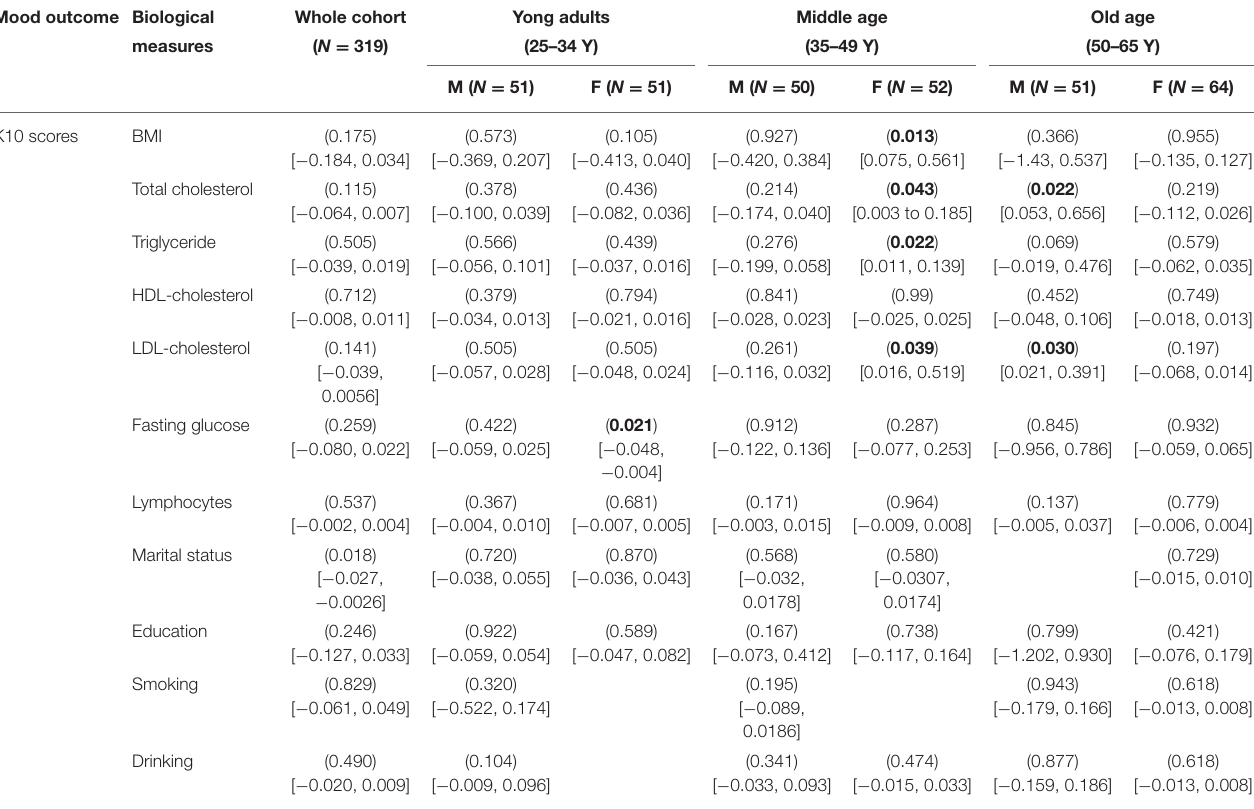
TABLE 2 | Multivariate general linear regression, stratified by age and